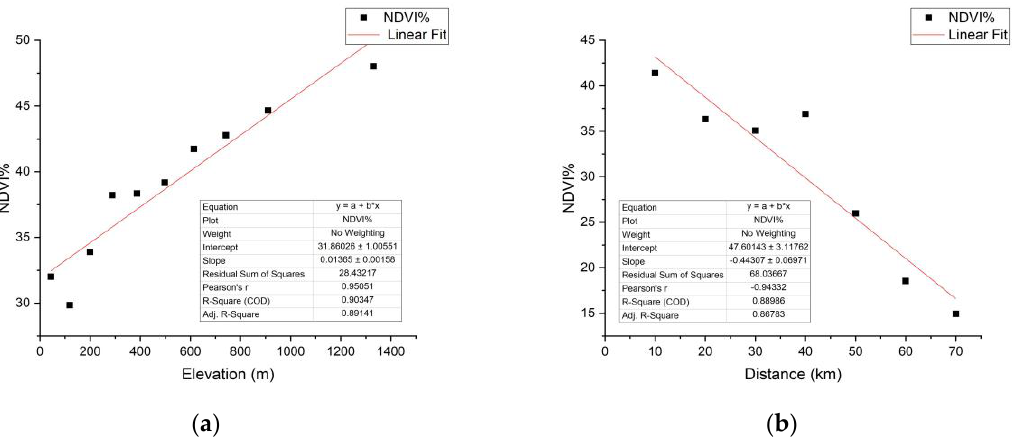
Figure 9. The linear regression results for Puerto Rico. ( a ) The strong positive relationship between mean NDVI% and elevation; ( b ) the strong negative relationship between mean NDVI% and distance.